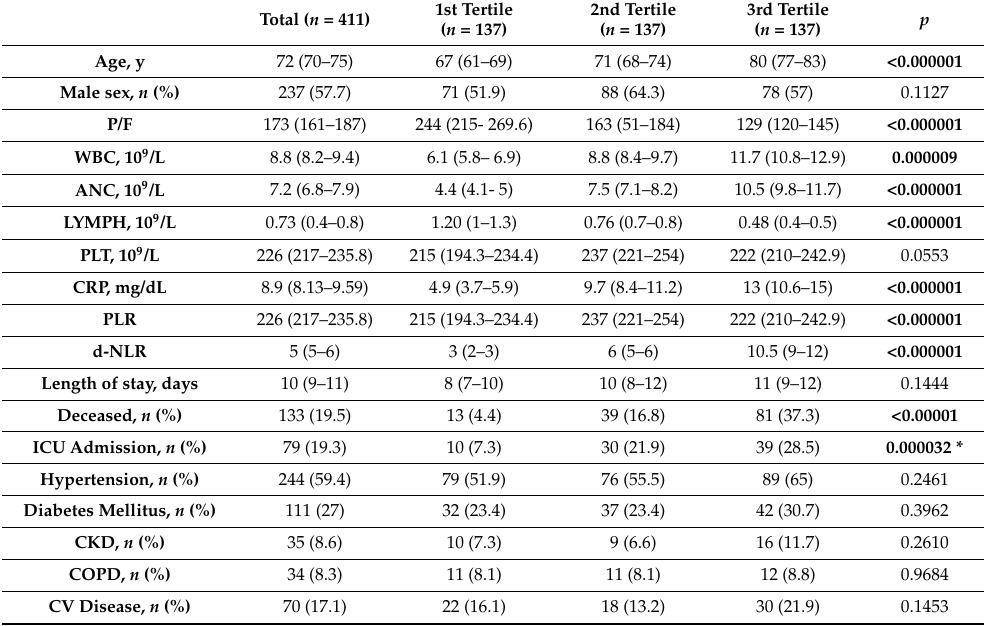
Table 2. Baseline demographic, laboratory, and clinical characteristics of the sample and features of different subgroups based on NLR tertiles. Reported in bold is the significance between tertiles. * Significant difference from the first tertile.